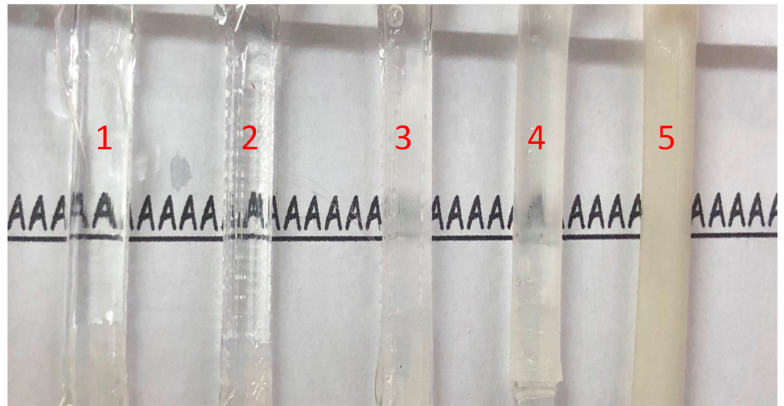
Figure 8. The transparency of the various tubes used to simulate blood vessels. Obviously, the letter “A” appears more clearly through Tube 1, which was fabricated using the method proposed in Section 3.2.